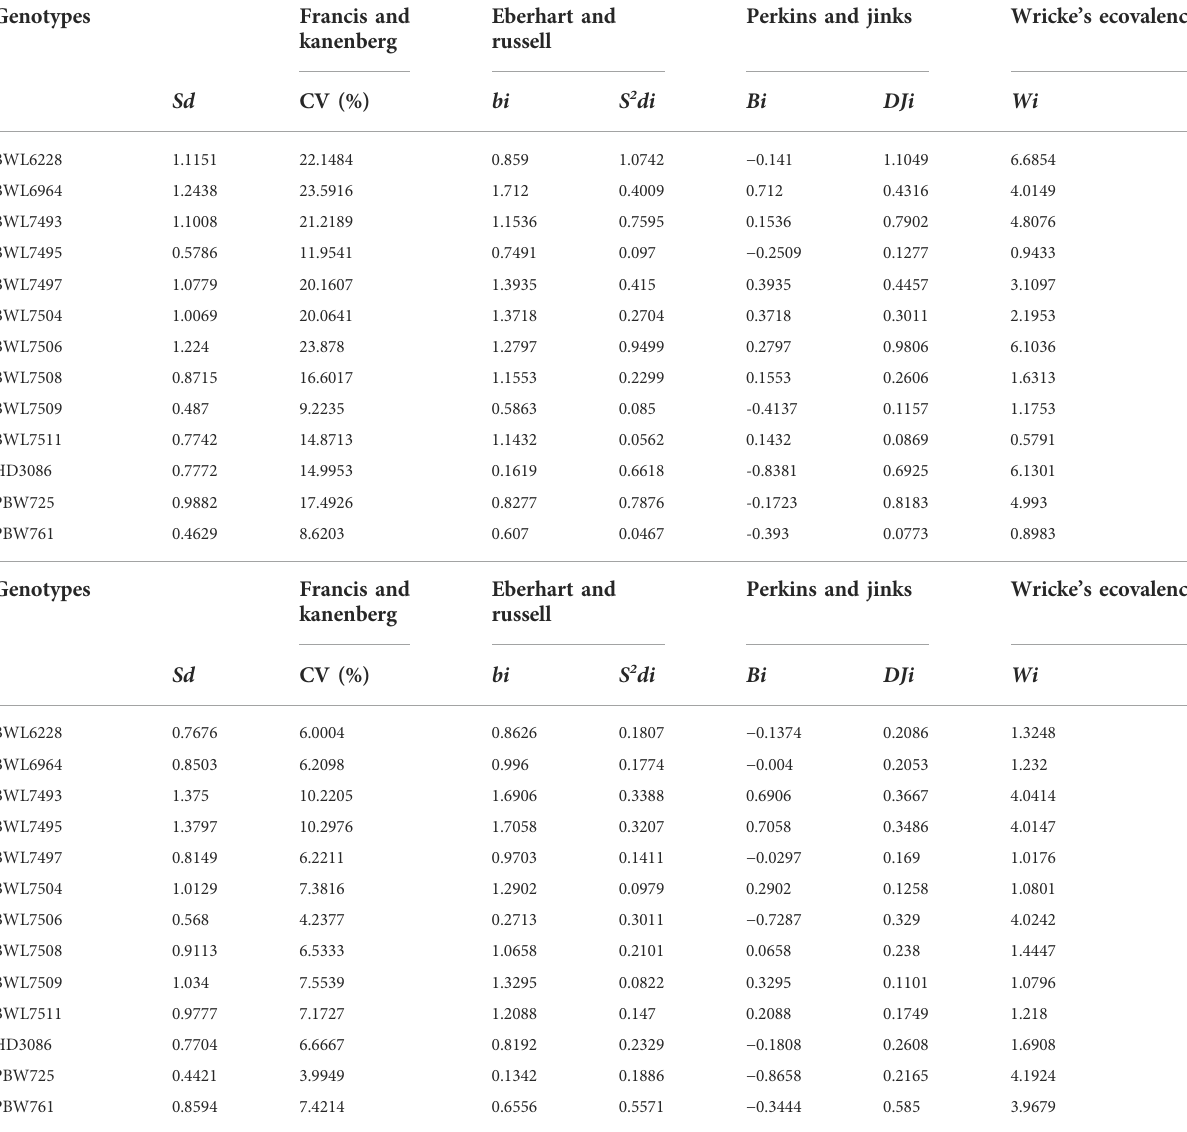
TABLE 4 Six univariate stability parameters and standard deviation for (A) yield and (B) GPC of 13 wheat genotypes across four locations (Ludhiana, Ballowal, Patiala, and Bathinda) of Punjab in two consecutive years 2019 – 20, and 2020 – 21. (A) Yield and (B) Grain protein content (GPC). Genotypes Francis and Eberhart and Perkins and kanenberg russell